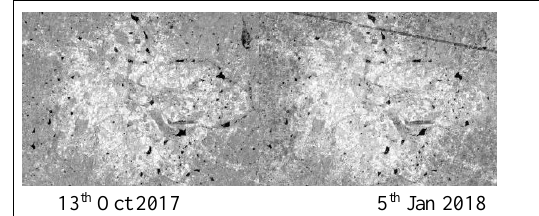
Figure 2: Sigma Naught Sentinel -1A SAR Images